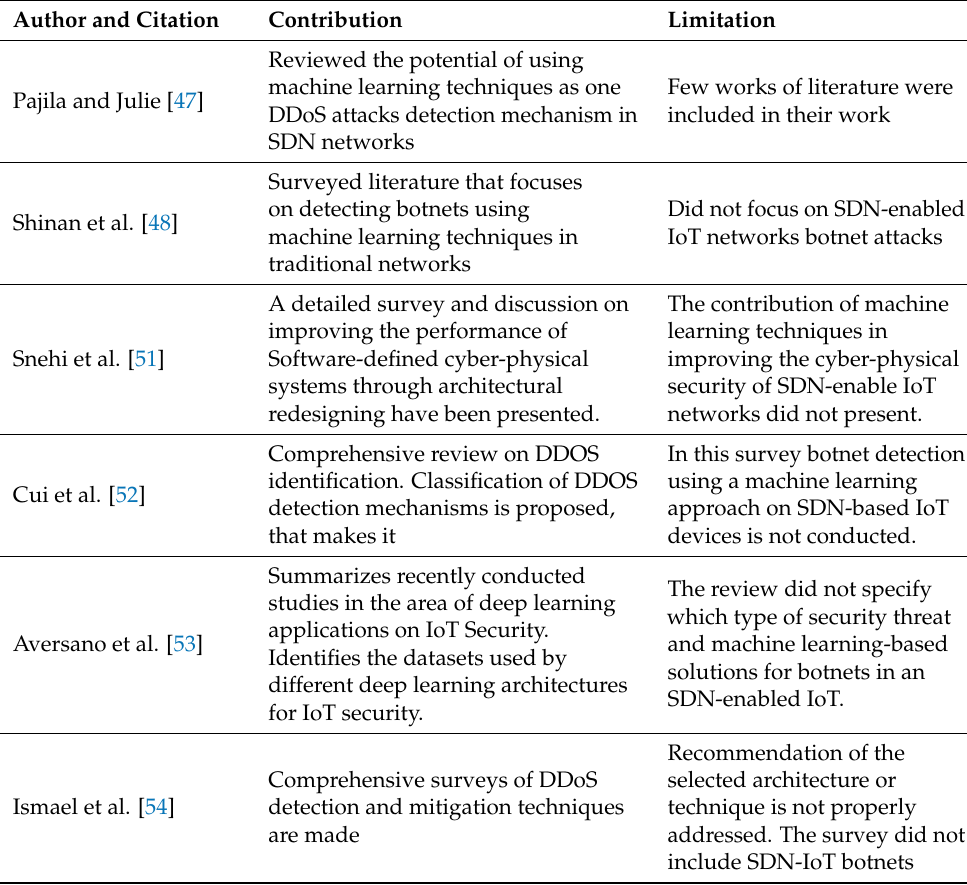
Table 1. Summary of Related